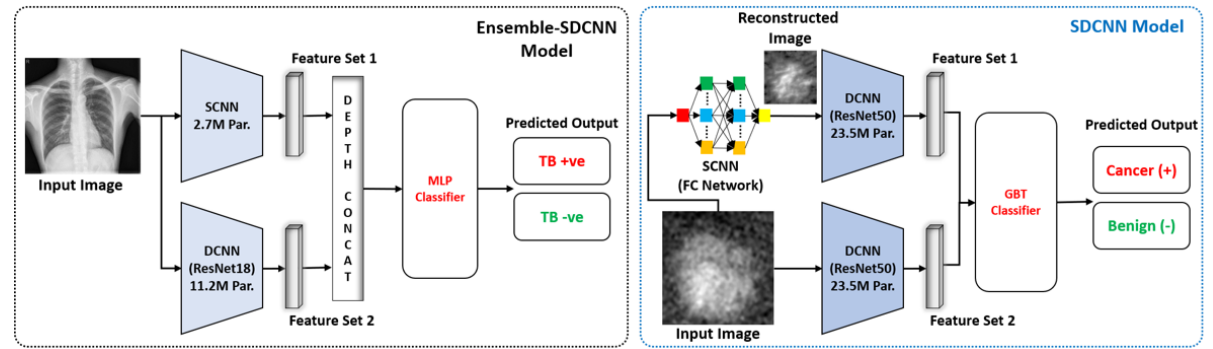
Figure 3. Overall structural comparison of our proposed ensemble-SDCNN (left) and existing SDCNN model (right). MLP: multilayer perceptron; GBT: gradient boosted